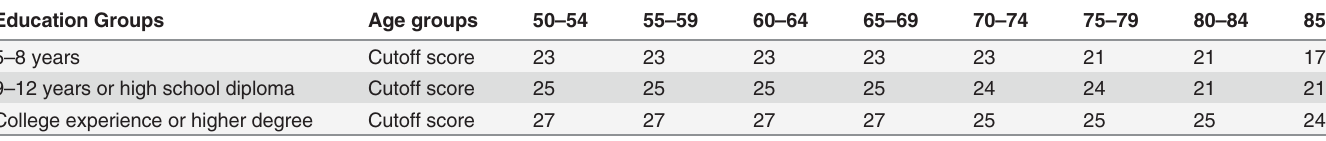
Table 2. Mini Mental Examination Test (MMSE): cut-off scores for